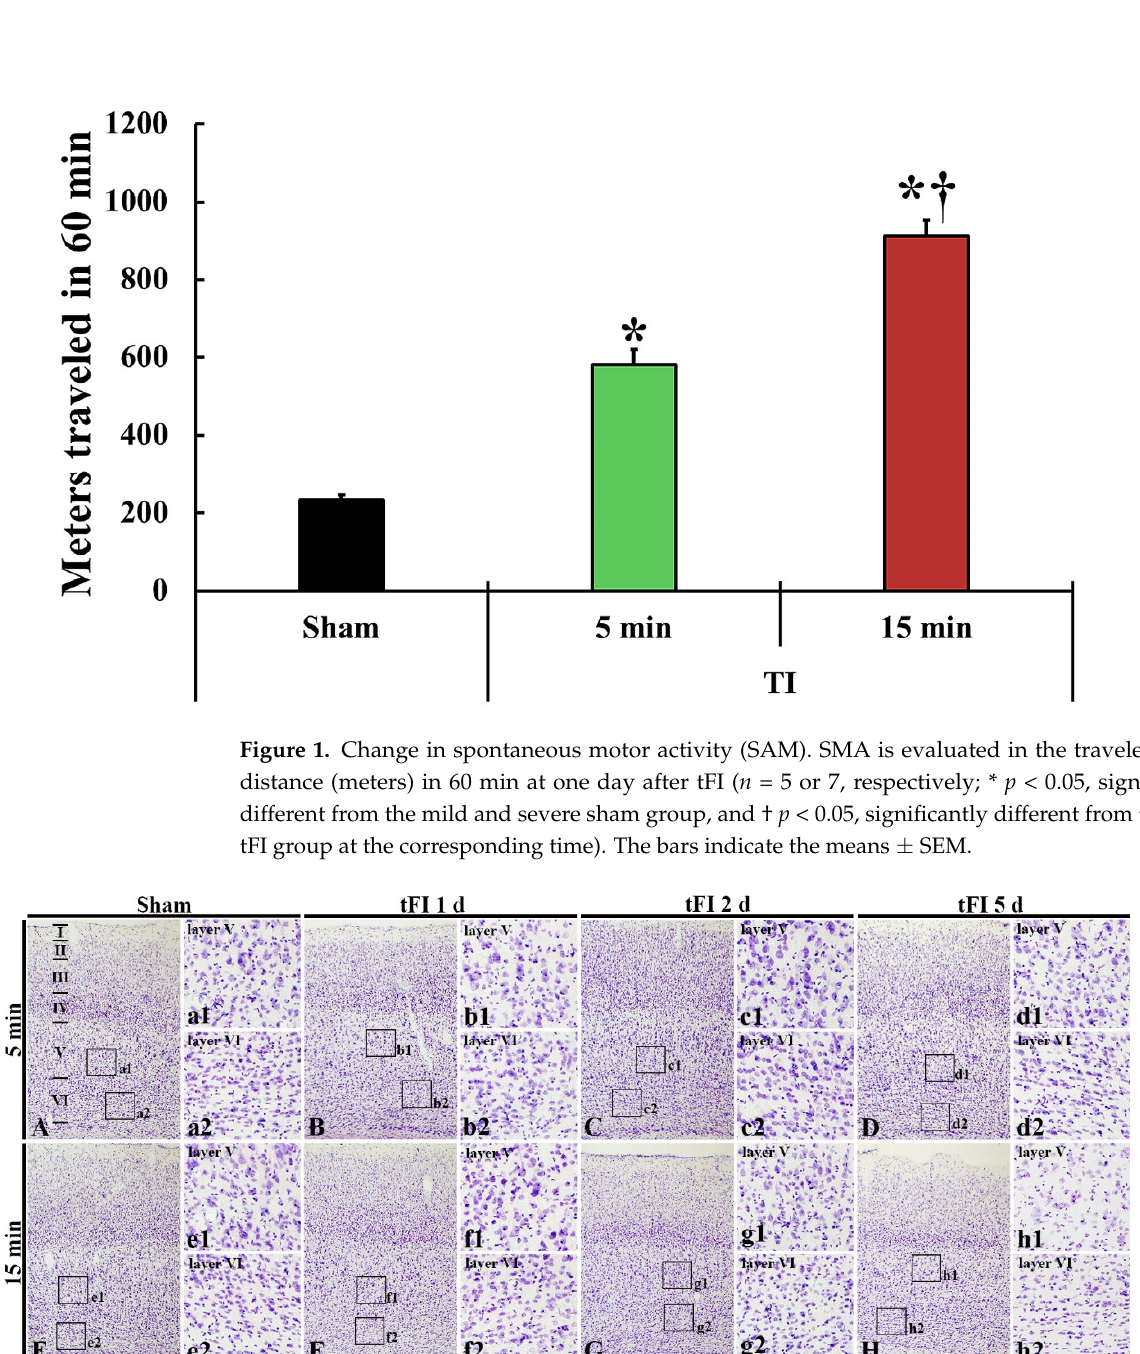
Figure 2. CV staining in the motor cortex of mild sham ( A , a1 , a2 ), mild tFI ( B – D , b1 – d1 , b2 – d2 ), severe sham ( E , e1 , e2 ), and severe tFI ( F – H , f1 – h2 , f2 – h2 ) groups at one day ( B , b1 , b2 , F , f1 , f2 ), 2 ( C , c1 , c2 , G , g1 , g2 ) and five days ( D , d1 , d2 , H , h1 , h2 ) after tFI. At five days after tFI, CV-cells are apparently decreased and damaged in layers V and VI ( d1 , d2 , h1 , h2 ) in both of the tFI groups: more reduction and damage of CV-cells are shown in the severe tFI group ( h1 , h2 ) than the mild tFI group. Scale bars = 200 µ m ( A – H ) and 50 µ m ( a1 – h1 , a2 – h2